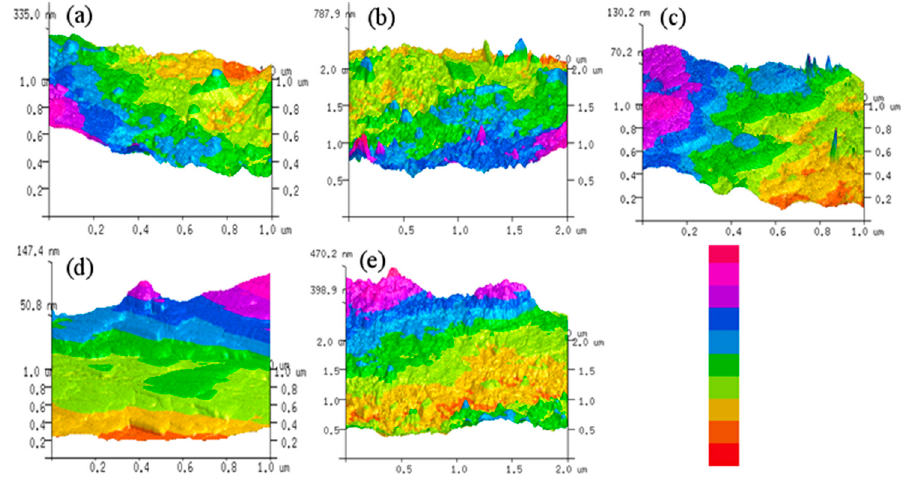
Figure 4. AFM images of the primary and the modified membranes. ( a ) Kevlar, ( b ) 2.5% nano-BC/Kevlar, ( c ) 5% nano-BC/Kevlar, ( d ) 7.5% nano-BC/Kevlar, and ( e ) 10% nano-BC/Kevlar. The surface roughness values, i.e., R a (average roughness), R rms (root mean square